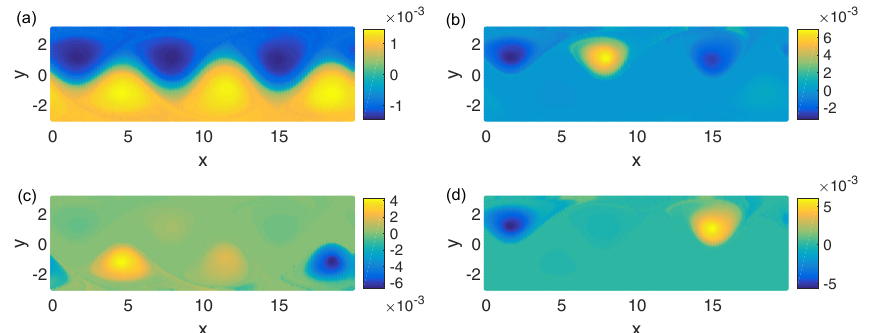
Figure 3. Leading eigenvectors v 2 – v 5 (from a to d ) of the generalized graph Laplacian eigenvalue problem Eq. (7) for the network con- structed from high-resolution initial data in the Bickley jet (case i) with (cid:15) = 0 . 2.